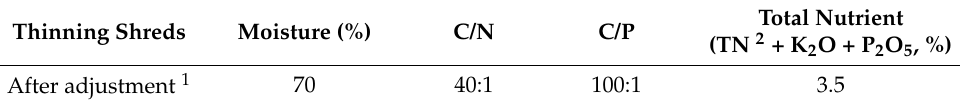
Table 1. Characteristics of thinning shreds.